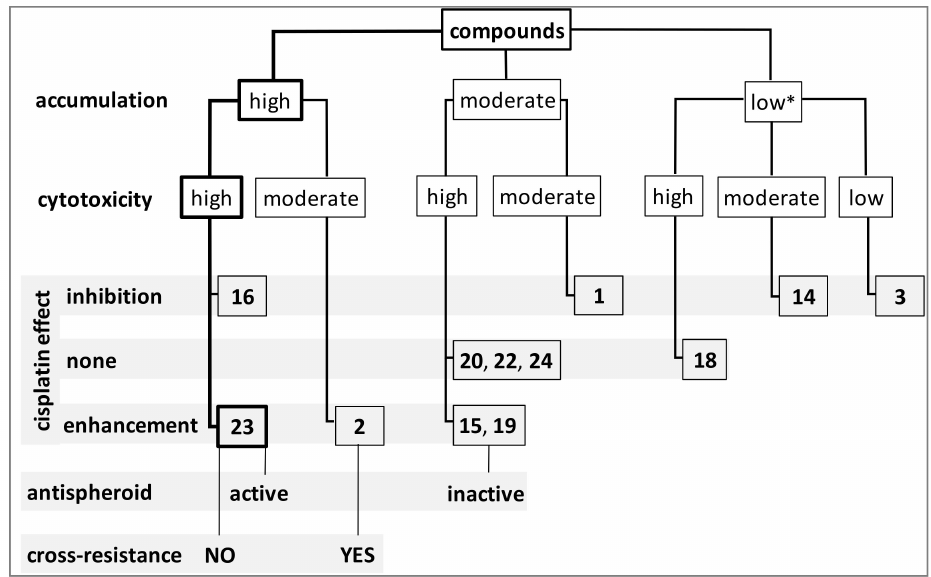
Figure 14. Selection of the lead compound 23 with the best anticancer activity: high intracellular accu- mulation, high toxicity against cisplatin-resistant cells, increase in the cytotoxic effect of cisplatin on cisplatin-resistant cells, active against cancer spheroids, and does not induce cross-resistance to anti- cancer drugs (cisplatin, carboplatin, paclitaxel, doxorubicin, and gemcitabine). Inhibitor—compound decreasing cisplatin effects; none—not active compound; amplifier—compound augmenting cisplatin effect; low*—relatively low accumulation, twice as high as